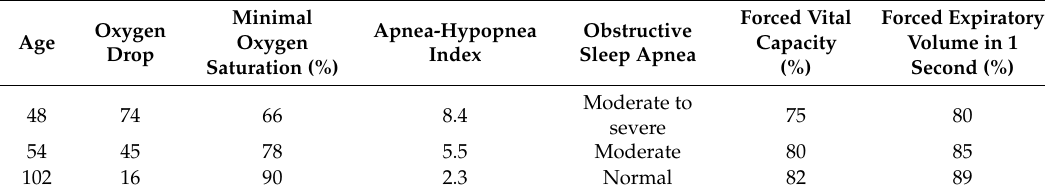
Table 1. Patient 1’s respiratory function and sleep test.